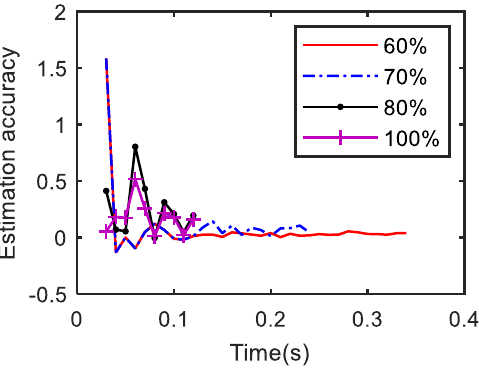
Figure 16. Estimation accuracy results under different duty cycles of TB solenoid valve.